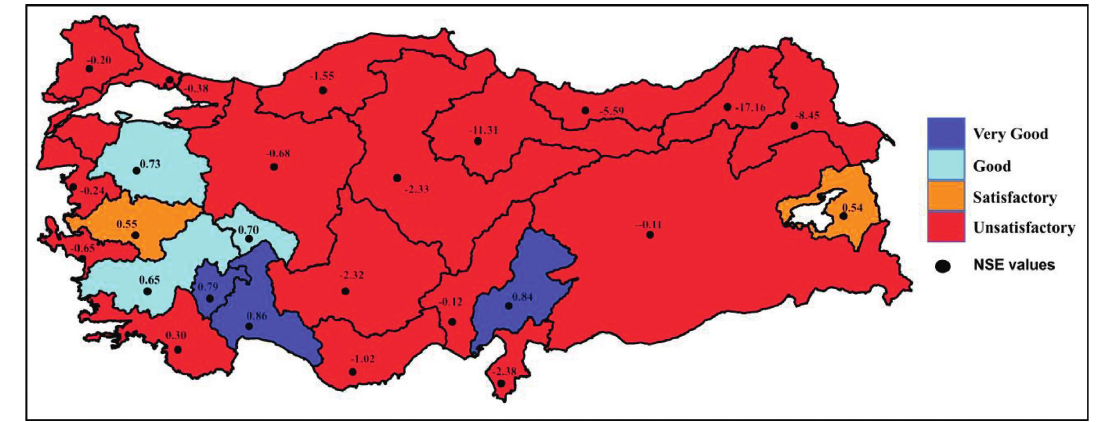
Figure 9: Results of NSE evaluation for CFSR